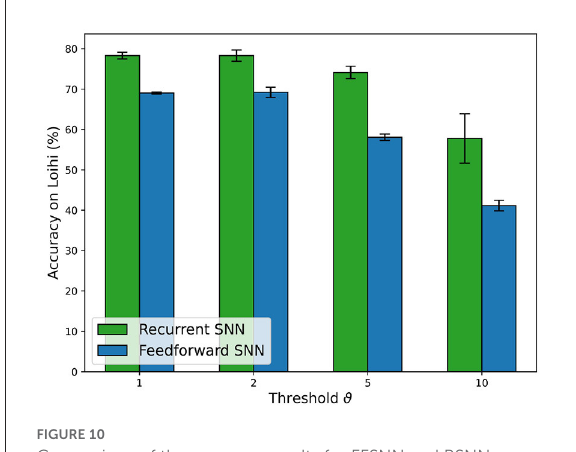
FIGURE10 Comparison of the accuracy results for FFSNN and RSNN on Loihi with the best parameters found by the two-stage HPO for each encoding